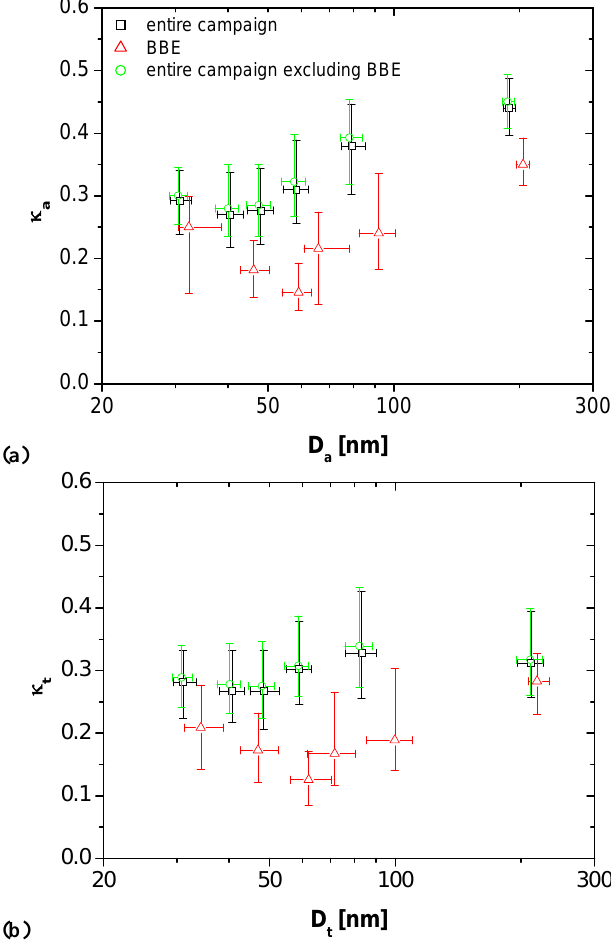
Fig. 6. Hygroscopicity parameters (a) for the CCN-active particles ( κ a ) and (b) for the total aerosol ( κ t ) averaged over different peri- ods: the entire campaign, the Biomass Burning Event (BBE) and the campaign excluding the biomass burning event. The data points are median values corresponding to a given level of supersaturation, and the error bars extend to lower and upper